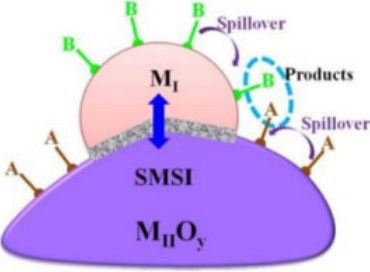
Figure 15. Spillover: an example of the bifunctional effect caused by SMSI. Reprinted with permission from Ref. [128]. Copyright 2017 Elsevier.